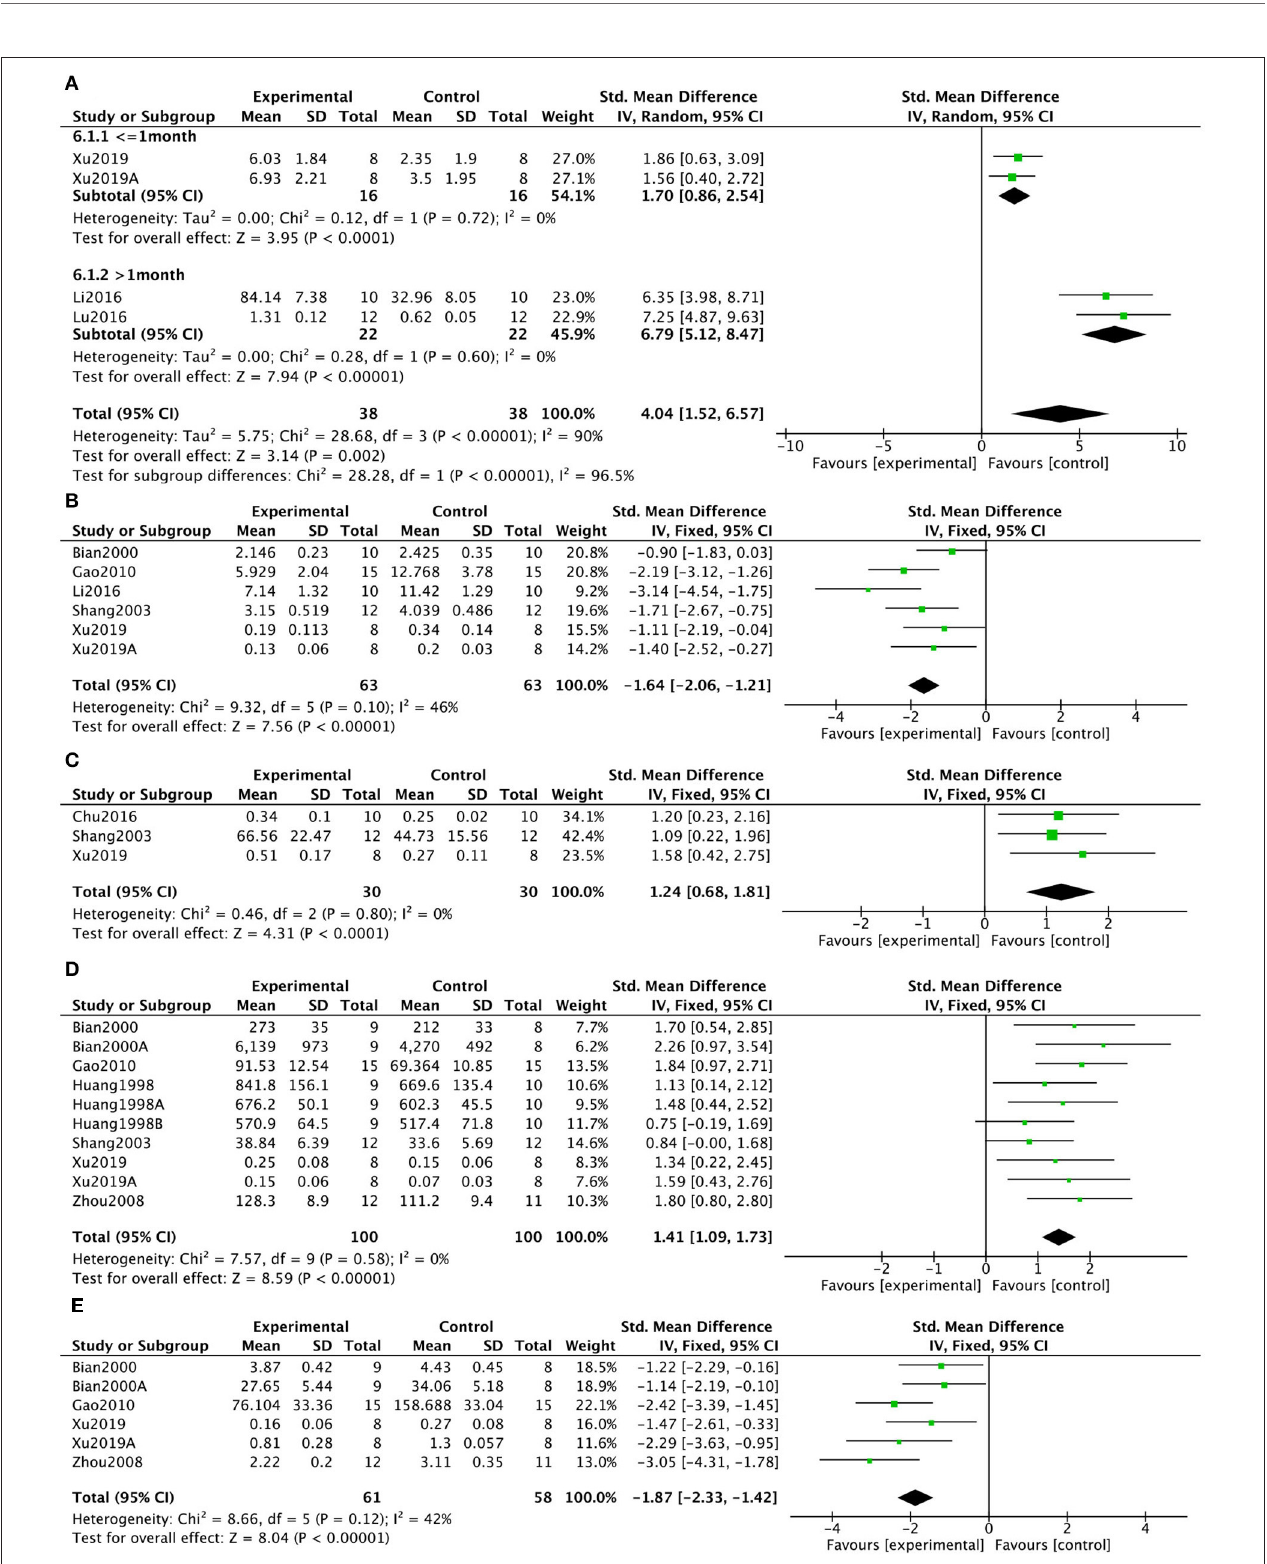
FIGURE 5 | Forest plot showing that KXS increased ACh levels (A) , decreased AchE activity (B) , increased ChAT activity (C) , increased SOD levels (D) , and decreased MDA levels (E) compared with controls in AD models.